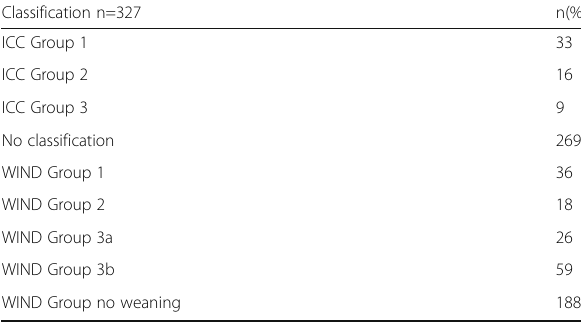
Table 2 (abstract 0136). Number of patients belonging to ICC and WIND